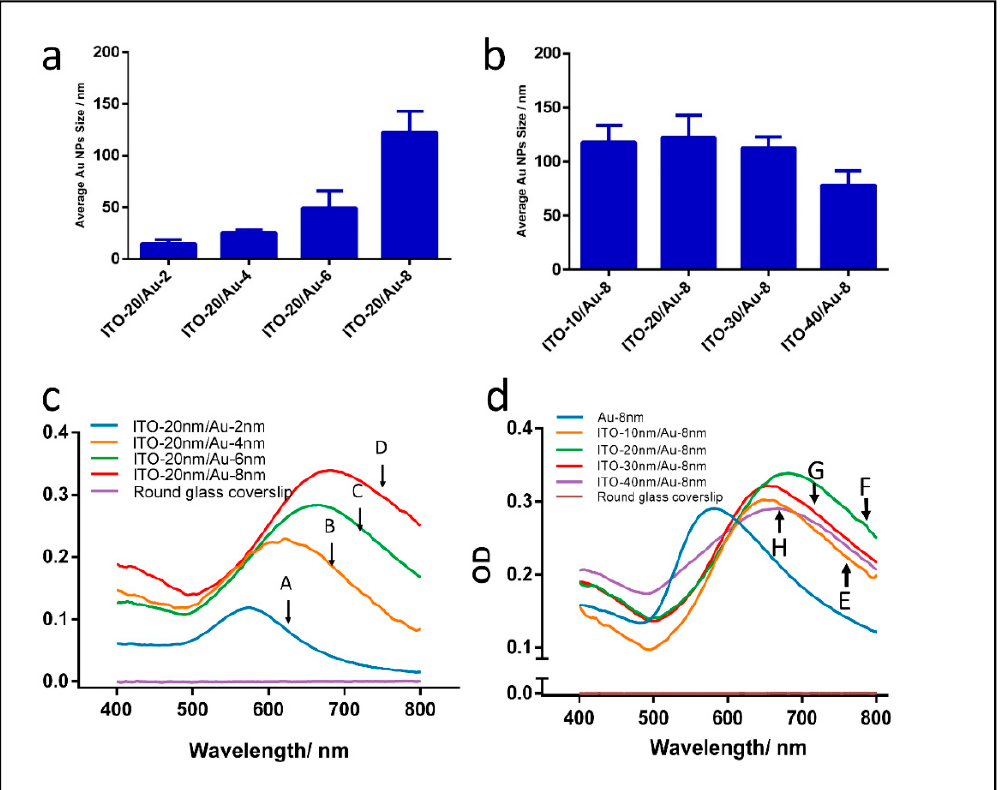
Figure 6. Estimation of nanoparticles sizes after two-step annealing protocol at 550 °C and their LSPR behavior in air-sensing conditions: ( a , c ) using annealed 20 nm ITO/(2–8 nm Au) and ( b , d ) (10–40 nm ITO)/8 nm Au coatings on coverslips.